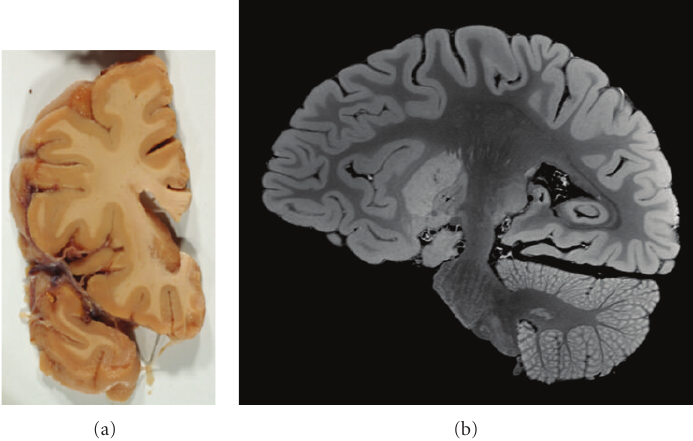
Figure 1: (a) photograph of a coronal slice of the post mortem MS hemisphere used for neuropathology. (b) MT-weighted SPGR image of the post mortem MS hemisphere at an isotropic resolution of 350 μ